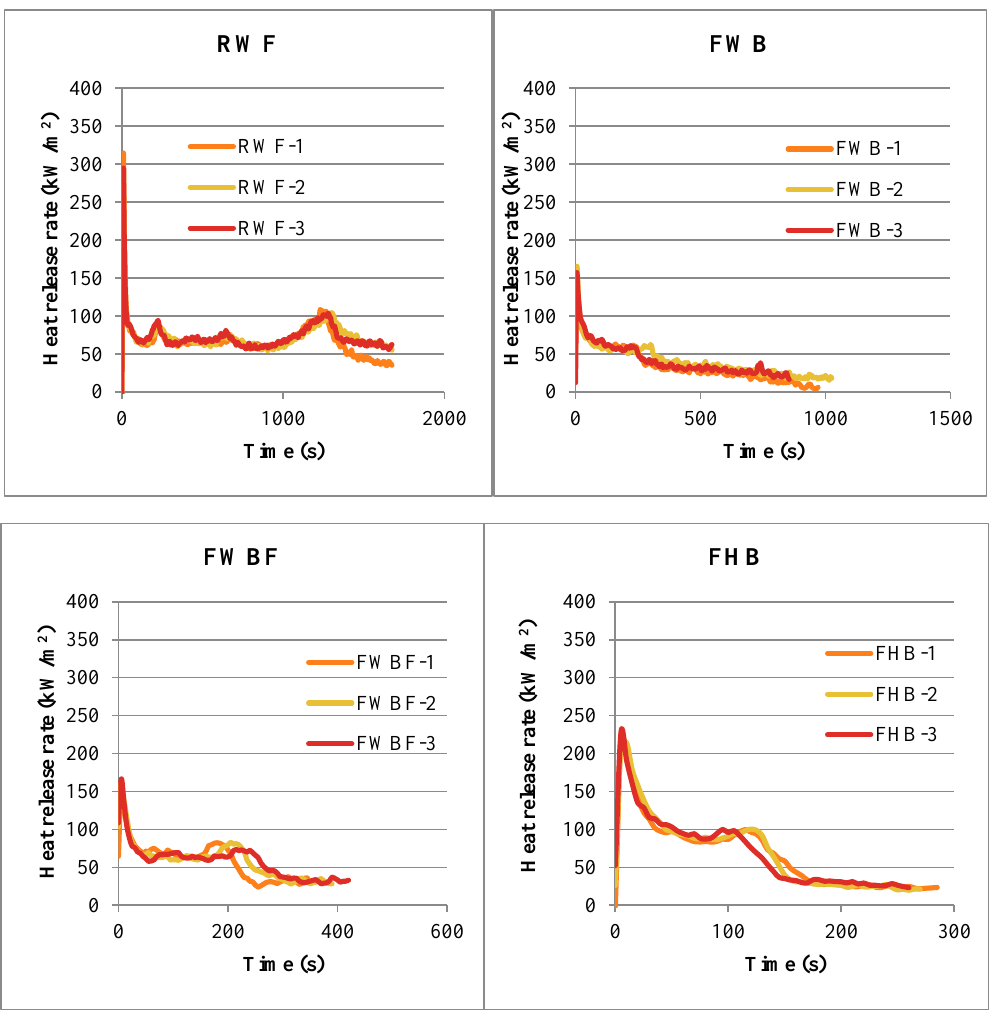
Figure 3. Heat release rate of EPS and five bio-based insulation materials.